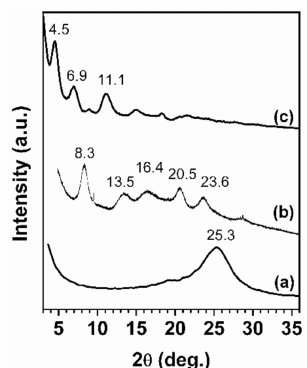
Figure 4. X-ray di ff raction patterns of r-GO (a) and hybrid monolithic polymer aerogels of sPS 0.8 / r-GO 0.2 (b), and PPO 0.8 / r-GO 0.2 (c) nanocomposites containing 20 wt.% of r-GO.